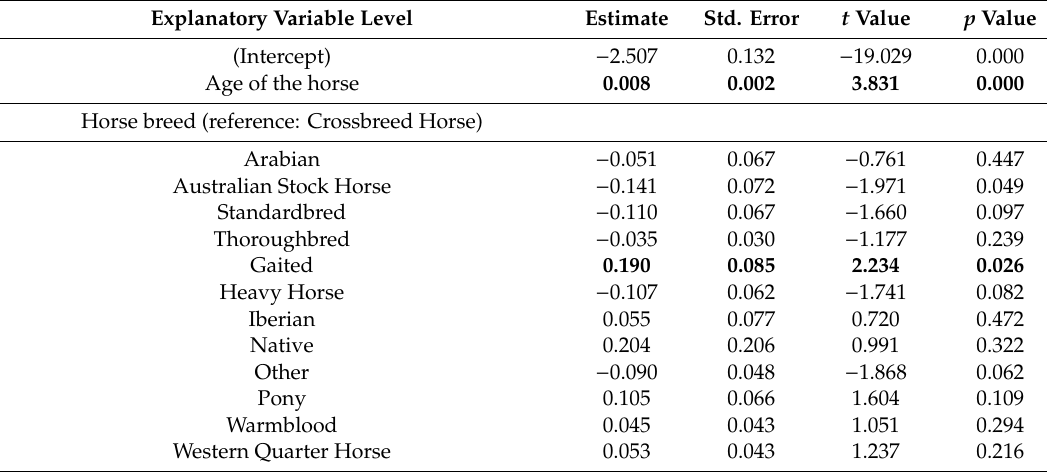
Horse breed (reference: Crossbreed